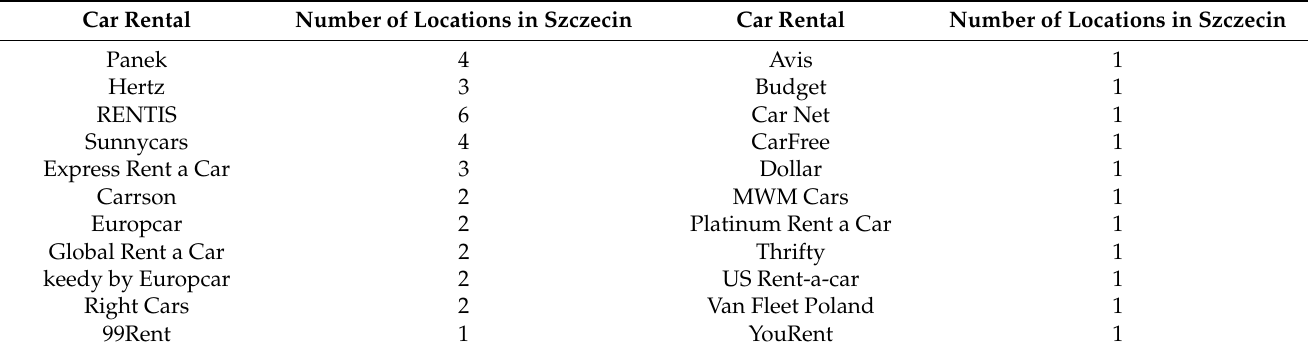
Table 1. Car rentals in Szczecin.